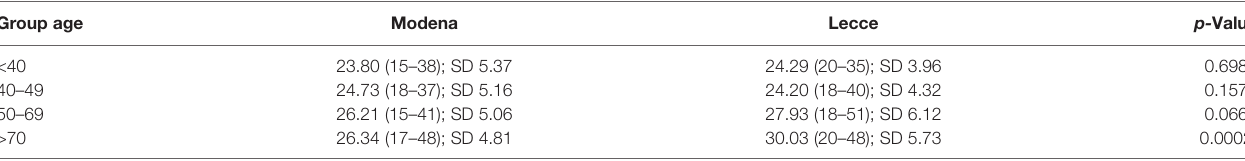
BMI, body mass index; SD, standard